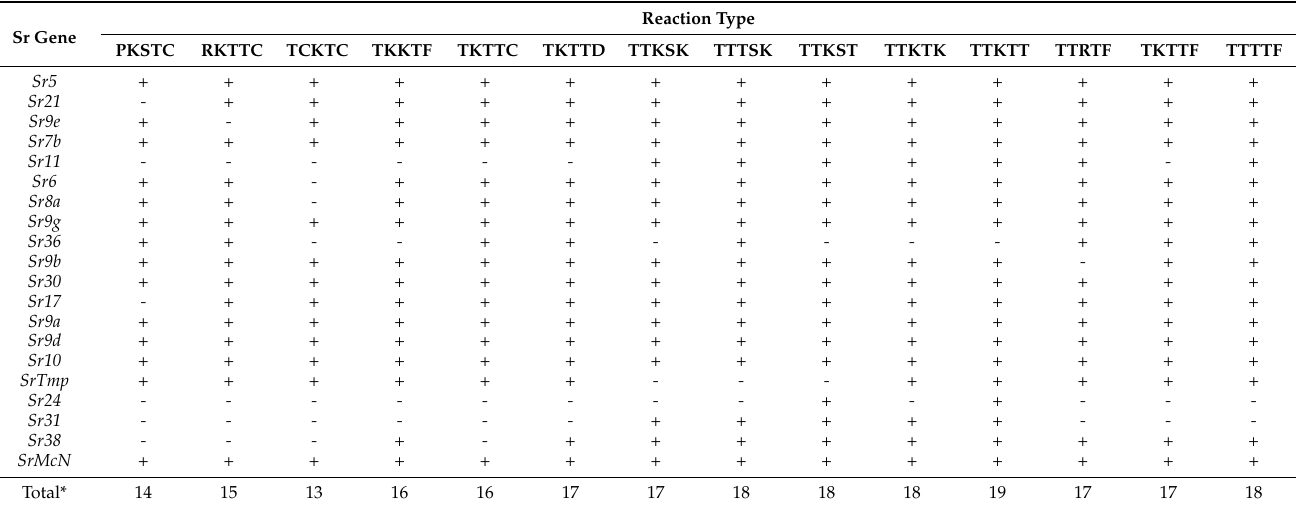
Table 7. Virulence formula of 14 Puccinia graminis races on 20 stem rust differential lines in Egypt and other